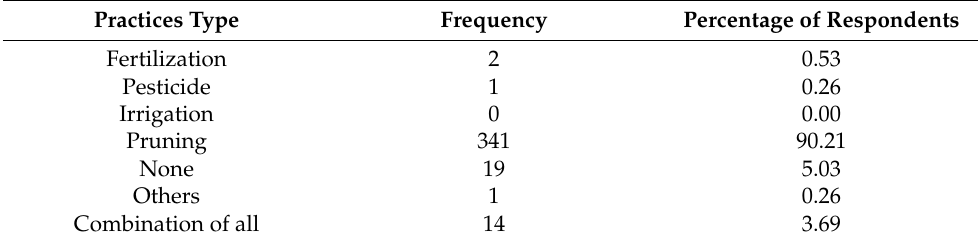
Table 4. Technical practices implemented by farmers.